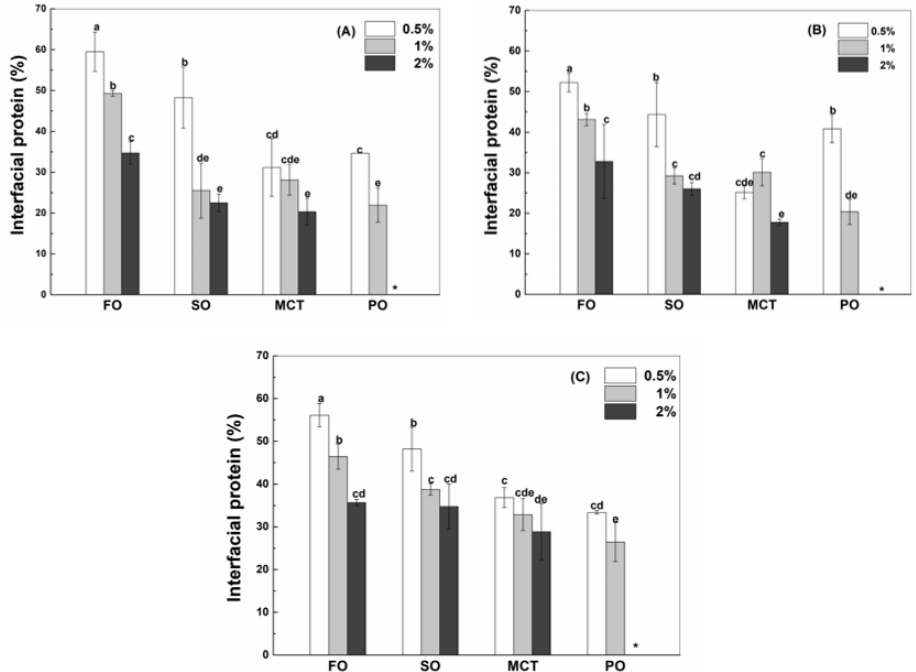
Figure 2. Interfacial percentage of native WPI ( A ), heat-denatured WPI ( B ) and sodium caseinate ( C ) in sunflower oil, fish oil, MCT and peppermint oil emulsions with 130 µ g/mL resveratrol. Protein concentrations are 0.5%, 1% and 2%. Different letters mean significant differences at p < 0.05. * Peppermint oil emulsions were unstable at 2% proteins.